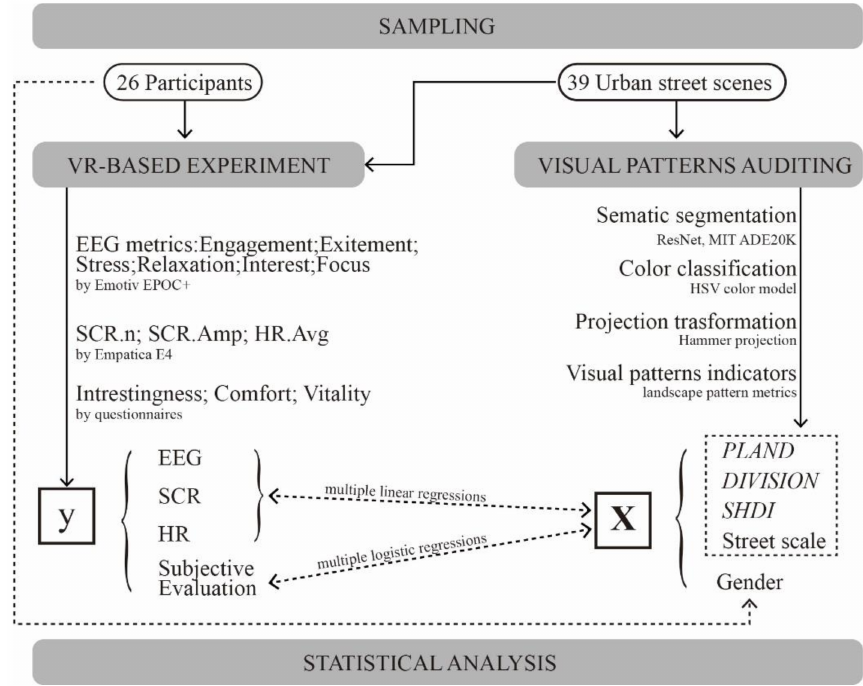
Figure 5. The analytical flowchart. Notes: EEG: electroencephalography; SCR: skin conductance responses; HR: heart rate; PLAND: percentage of landscape; DIVISION: landscape division index; SHDI: Shannon’s diversity